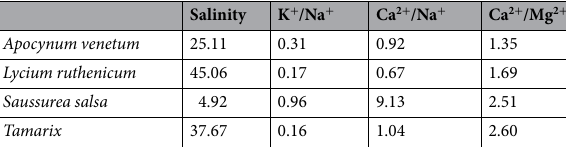
Table 2. The influence of the soil ion ratio on plant